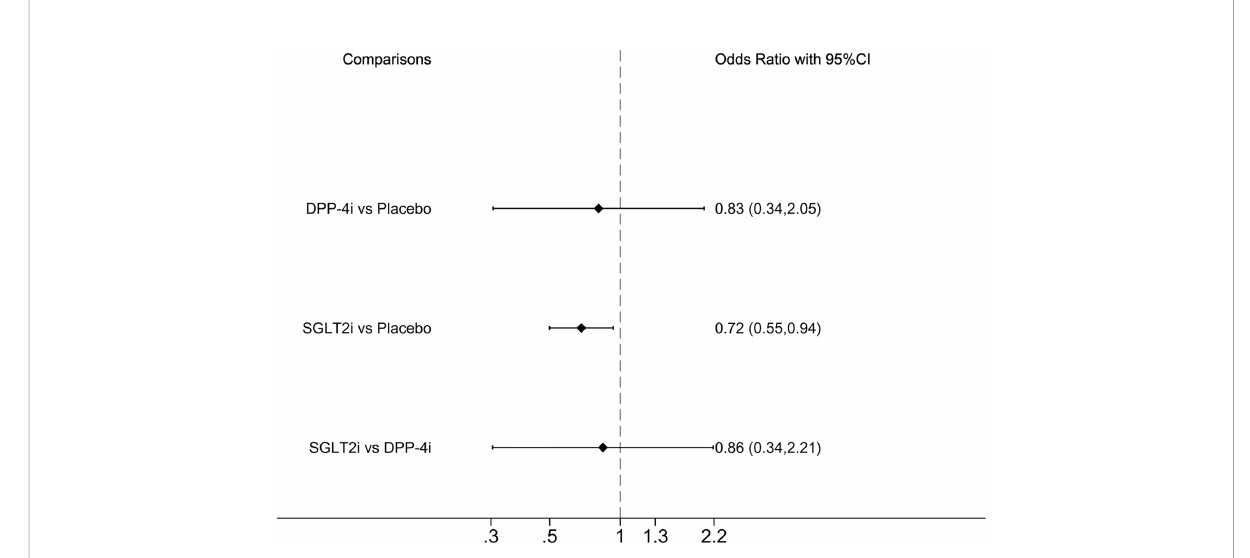
FIGURE 3 Forest plot of odds ratio comparing the all-cause mortality between each medicine class or between each medicine class and placebo.